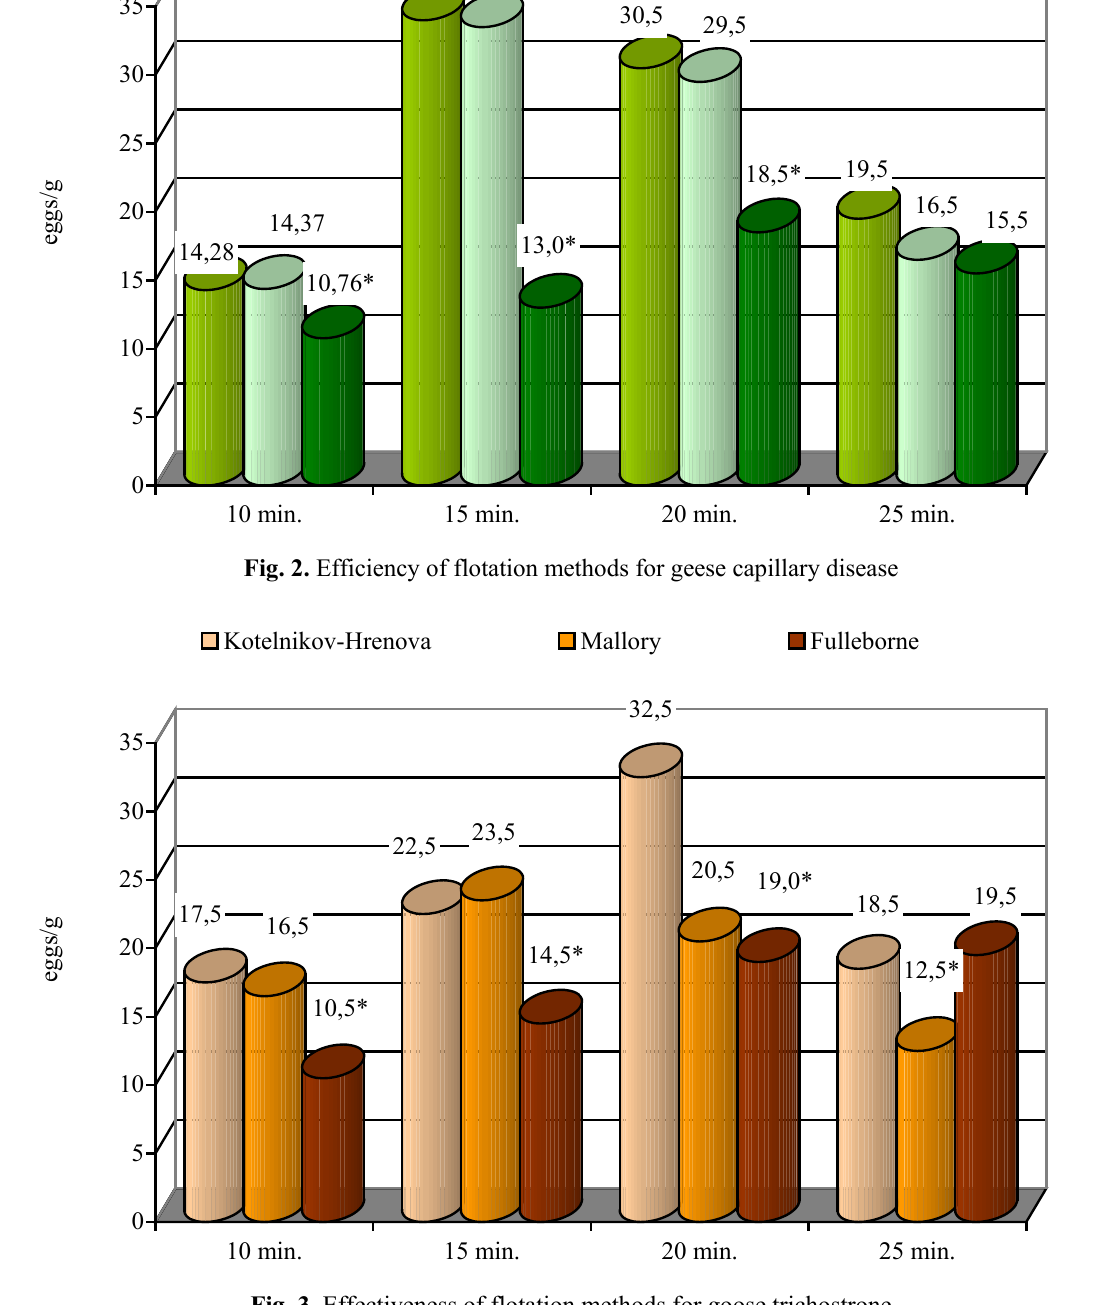
Fig. 3. Effectiveness of flotation methods for goose